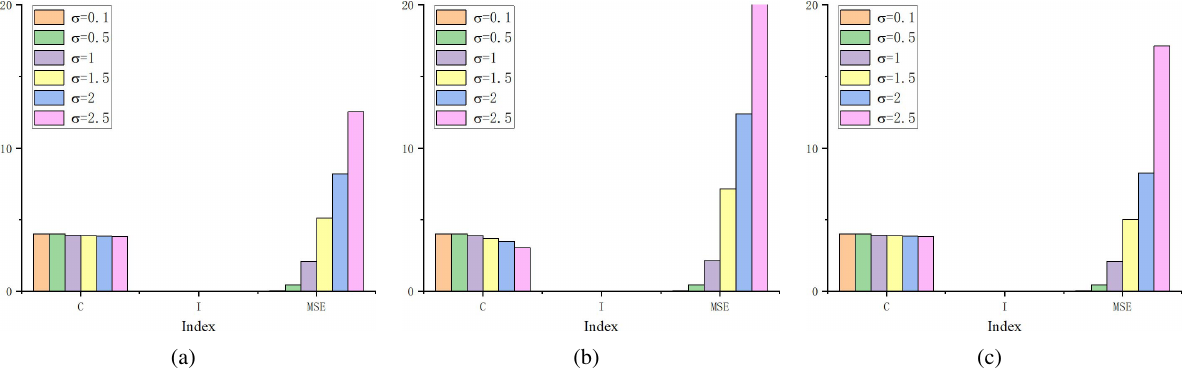
Fig. 6 Simulation results when N = 400, R = 30 and ρ = 0.1. (a) The result of ALASSO penalty function; (b) the result of LASSO penalty function; and (c) the result of SCAD penalty function. ALASSO, adaptive least absolute shrinkage and selection operator; LASSO, least absolute shrinkage and selection operator; SCAD, smoothly clipped absolute deviation.